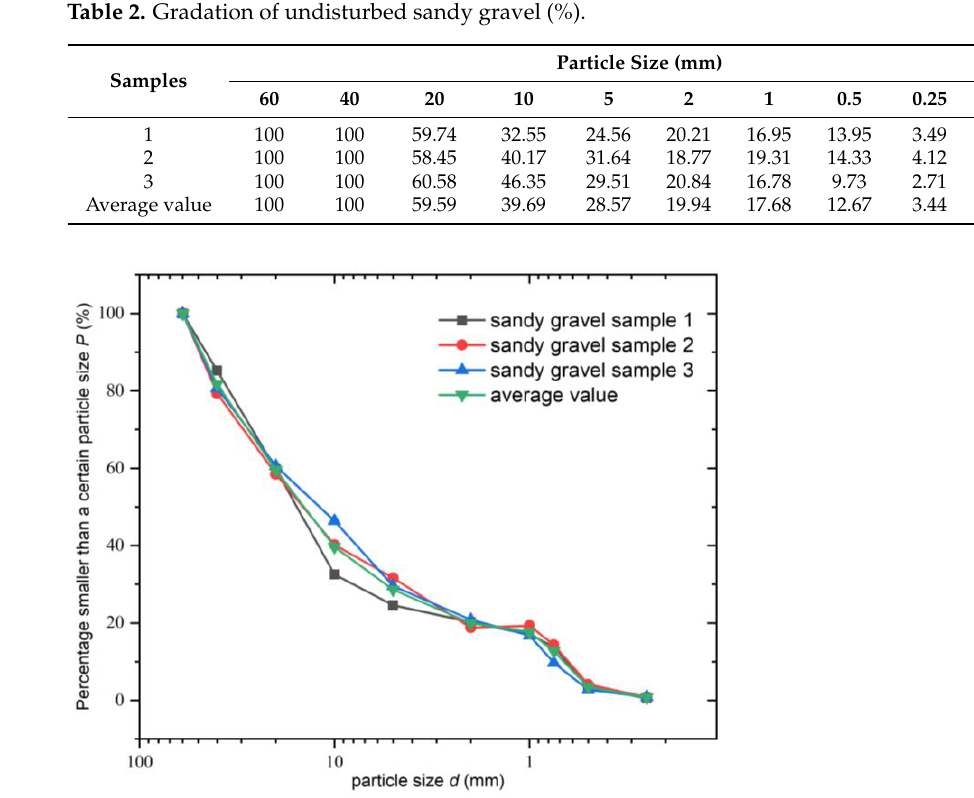
Figure 1. Undisturbed sandy gravel gradation curve.